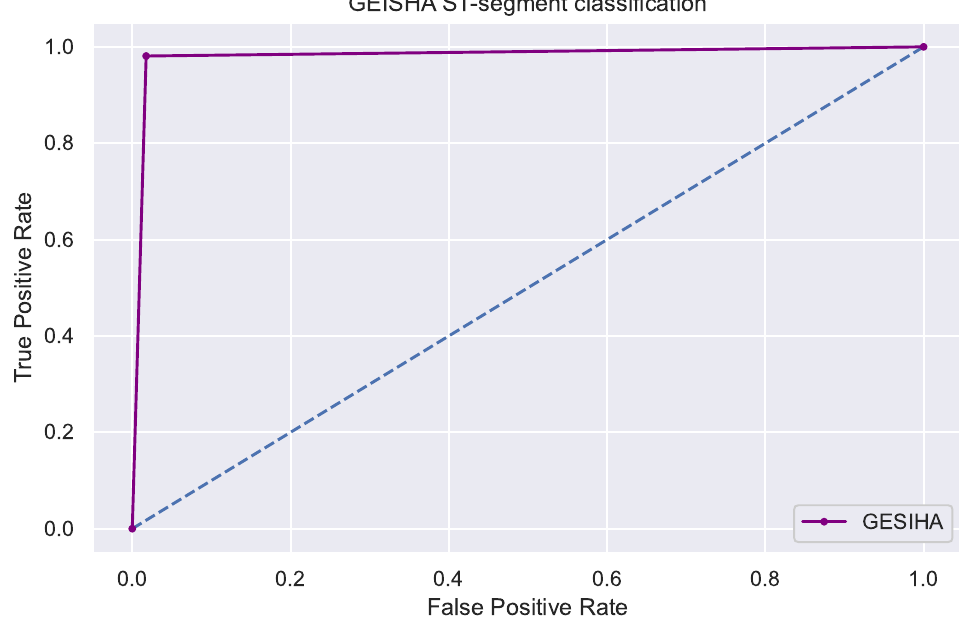
Figure 8. The area under the curve with binarization of the problem, considering only normal and abnormal beats (depression or elevation as